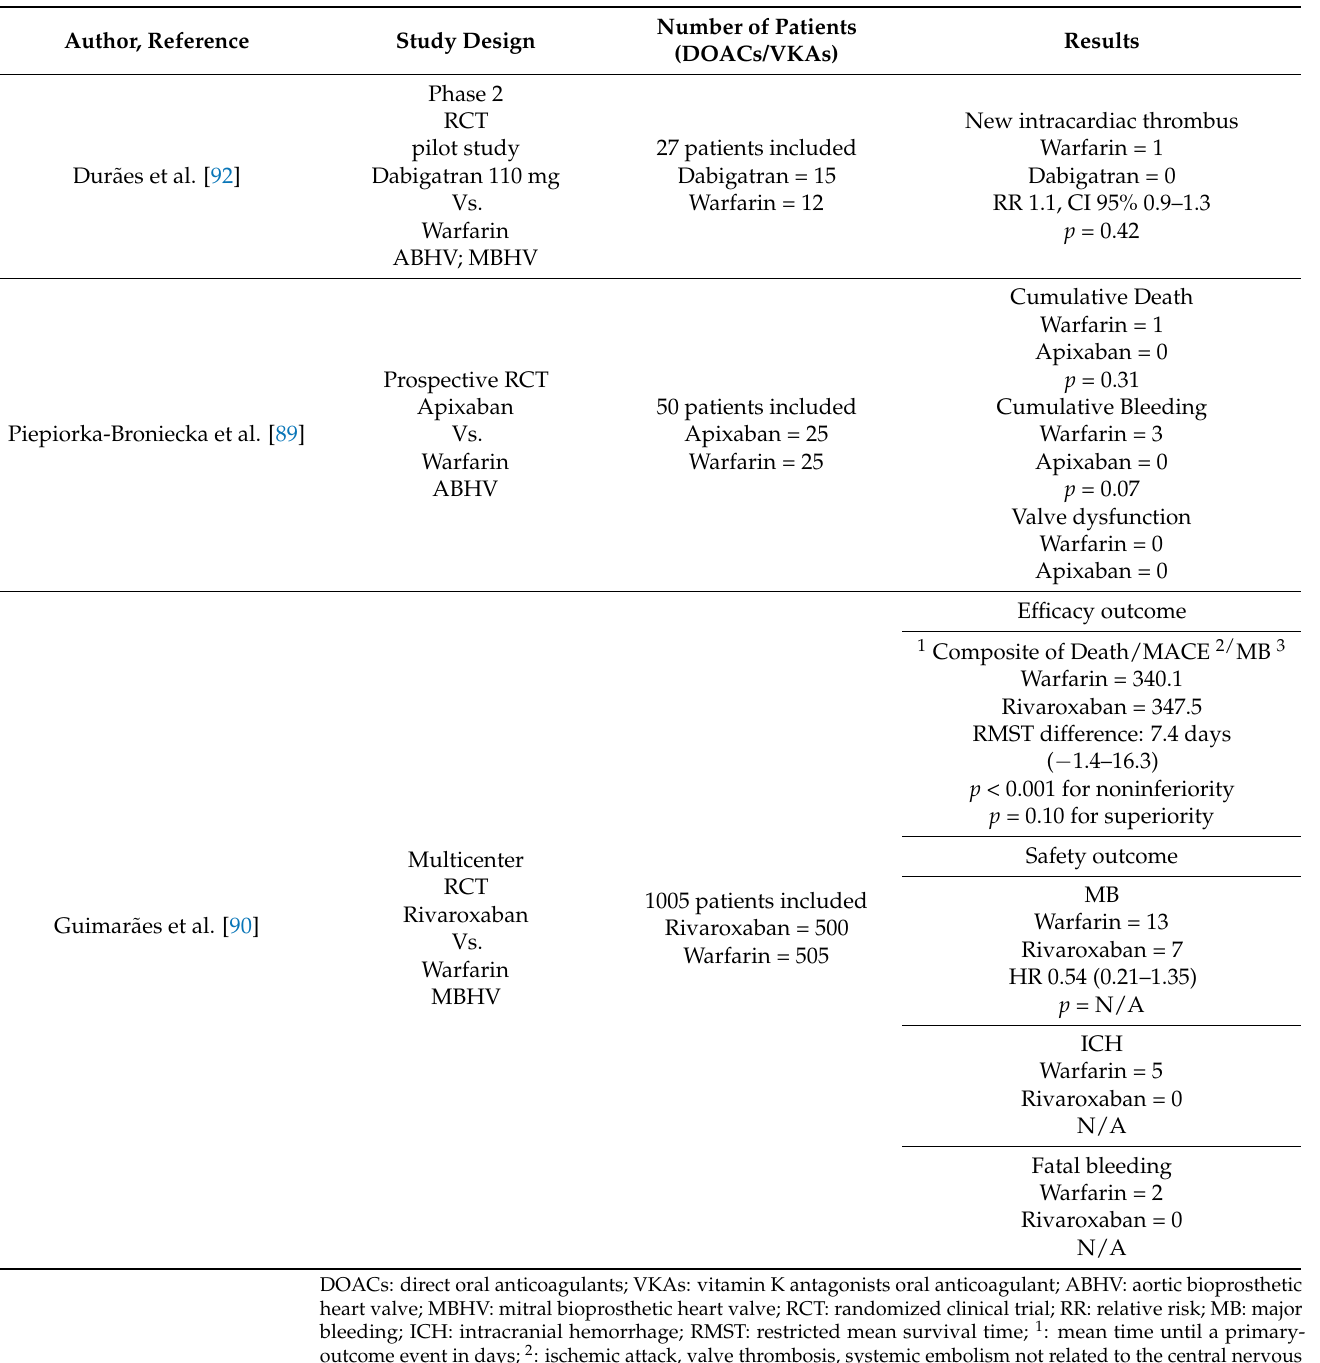
Table 6. Characteristics of the randomized clinical trials comparing Direct oral anticoagulants with vitamin K antagonist oral anticoagulants in AF patients with bioprosthetic valves or surgical valve